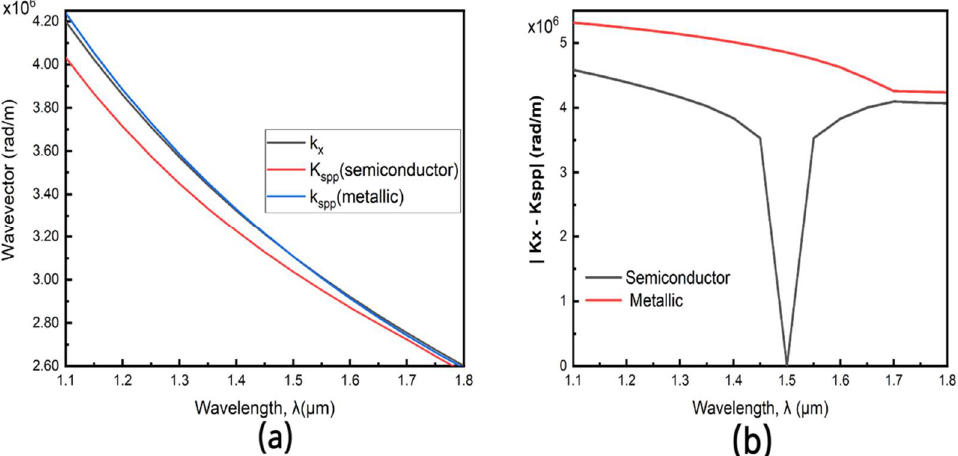
Figure 7. ( a ) Dispersion characteristics of the plasmonic slot and the silicon waveguide with VO 2 in both the metallic and semiconductor phases. The slot width (w) is 100 nm, the silicon waveguide is 430 nm wide and 220 nm high ( b ) Absolute value of spatial mismatch in the metallic (ON) and metallic (OFF).